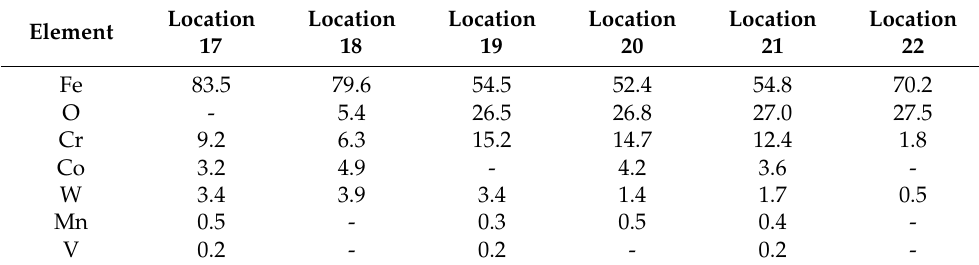
Table 6. Quantitative EDX analysis, sample MarBN oxidized for 2000 h at 650 ◦ C (in wt.%). Element